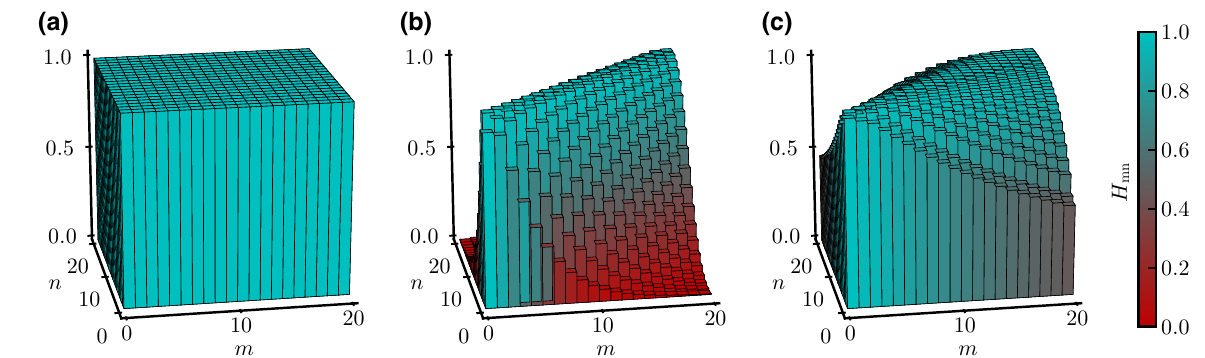
FIG. 4. Visualization of the matrix H for different realizations of phase measurements. (a) Canonical phase measurement ( CAN ). (b) Heterodyne detection ( HET ). (c) Adaptive homodyne detection ( AHD ). A good phase measurement is characterized by H mn = 1 for all m , n ; see (a). The comparison of (b) and (c) to H CAN in (a) therefore indicates a clear performance advantage of adaptive homodyne detection over heterodyne measurements for the realization of the logical M X measurement; see the main text for more details.